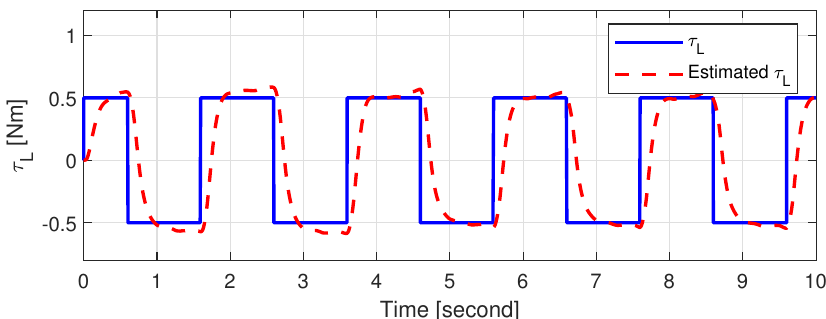
Figure 9. Load torque estimation performance of the nonlinear